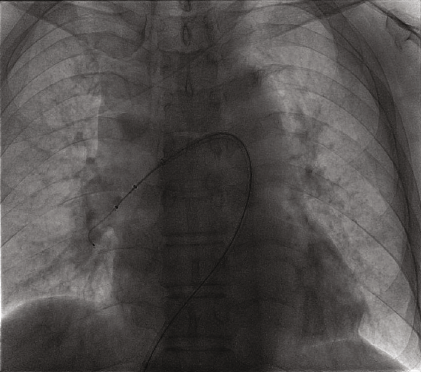
Figure 4: Angiographic imaging of Angiojet system in the second